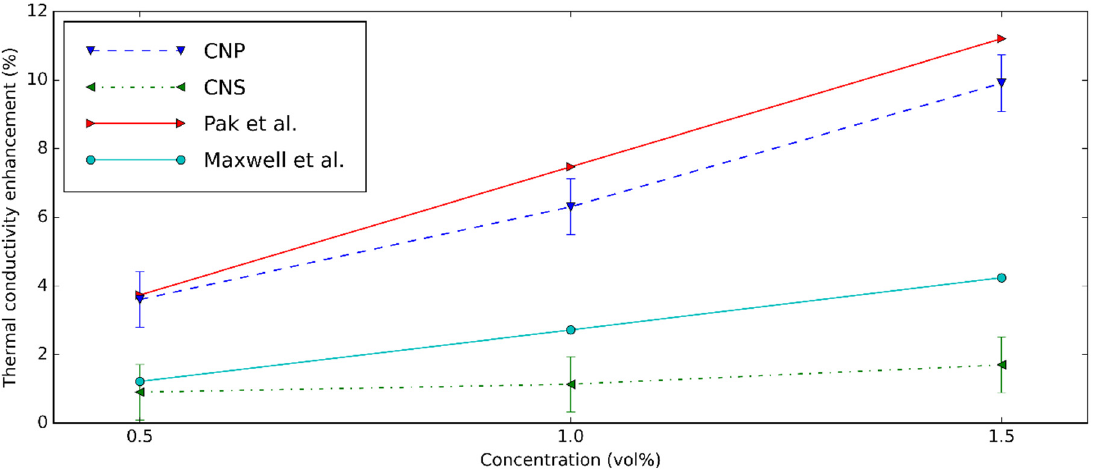
Figure 12. k enhancement of ( a ) CNS and ( b ) CNP nanofluids with different concentrations at dif- ferent temperatures.